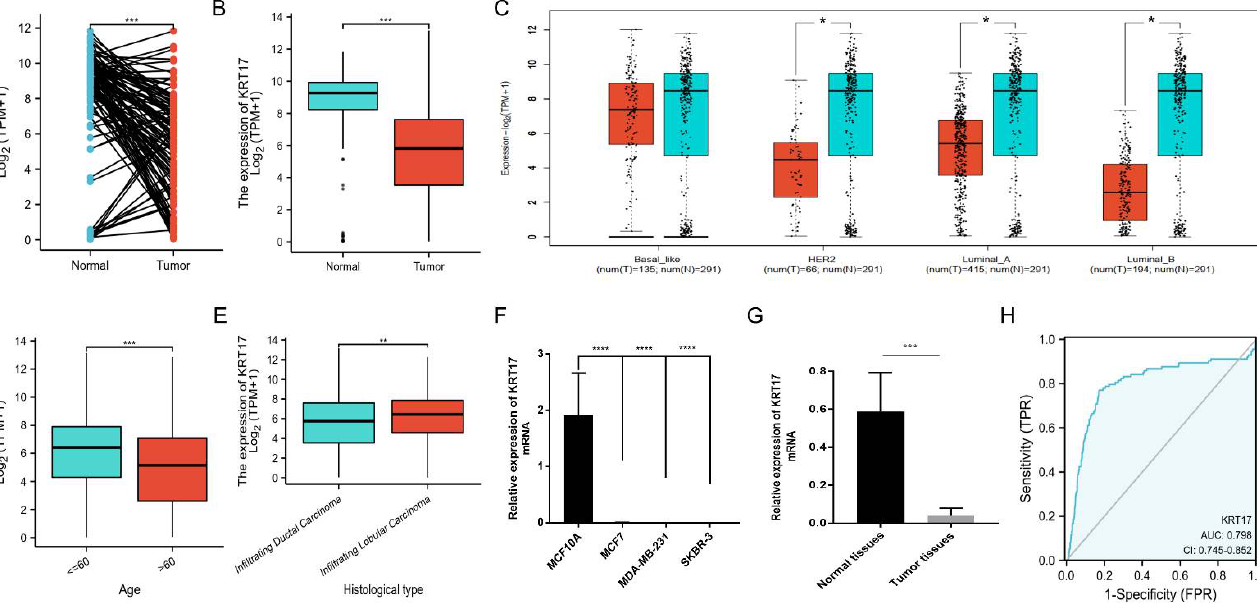
Figure 1. KRT17 expression patterns in BC. ( A ) KRT17 expression was significantly downregulated in paired BC tissues compared to adjacent normal tissues. ( B ) KRT17 expression was significantly lower in BC tumor tissues than in normal tissues. ( C ) The difference in KRT17 expression was more pronounced in HER2 + , luminal-A and luminal-B BC than in basal-like BC. ( D ) KRT17 expression in patients ≤60 years old was higher than that in patients ≥60 years old. ( E ) Patients with infiltrating ductal carcinoma had lower KRT17 expression than patients with infiltrating lobular carcinoma. ( F ) KRT17 expression in BC cell lines (MCF7, MDA-MB-231 and SKBR-3) was decreased compared with the normal breast epithelial cells (MCF10A) as assessed by qRT–PCR. ( G ) KRT17 expression was significantly downregulated in 10 paired clinical BC tissues compared with matched nonneoplastic tissues. ( H ) ROC analysis illustrated that KRT17 expression accurately distinguished BC tumor tissues from the normal tissues with an AUC of 0.798 (95% CI = 0.745−0.852). The data in A–E and H were from the TCGA-BRCA cohort. (“ns”, p ≥ 0.05; *, p < 0.05; **, p < 0.01; ***, p < 0.001; ****, p < 0.0001).